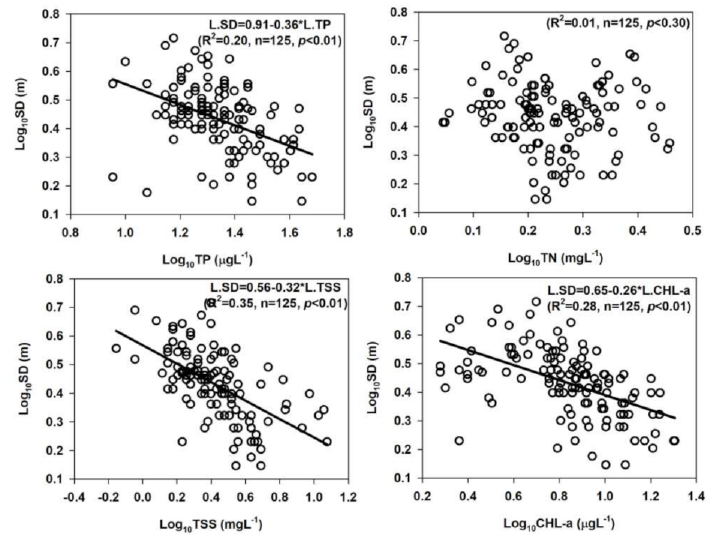
Figure 8. Empirical links between water transparency (SD), nutrients. TP: total phosphorus; TN: total nitrogen; suspended solids (TSS), and chlorophyll-a (CHL-a) in Daecheong Reservoir